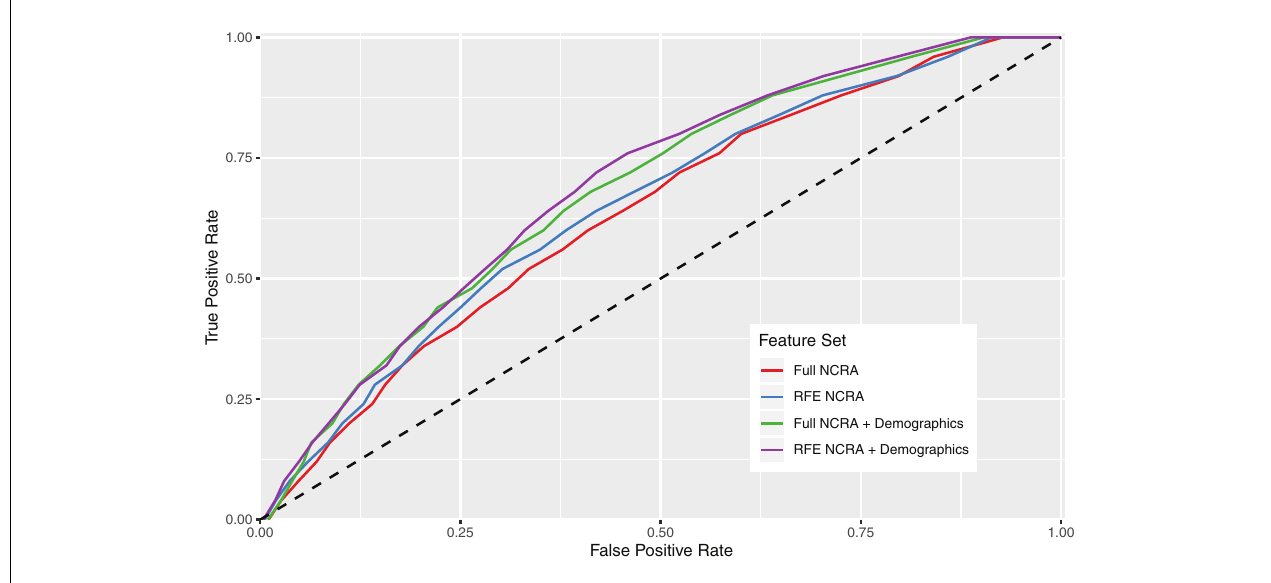
FIGURE 3 | Receiver operating characteristic curves illustrating predictive performance of the Glmnet machine learning method over all feature sets.